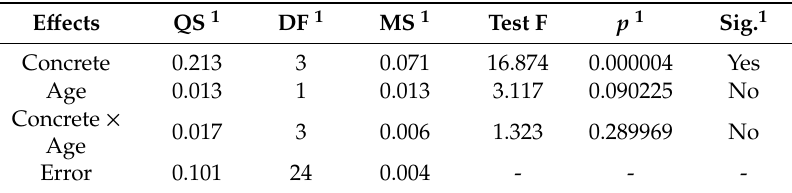
Table 8. Analysis of variance (ANOVA) of the capillarity water absorption.